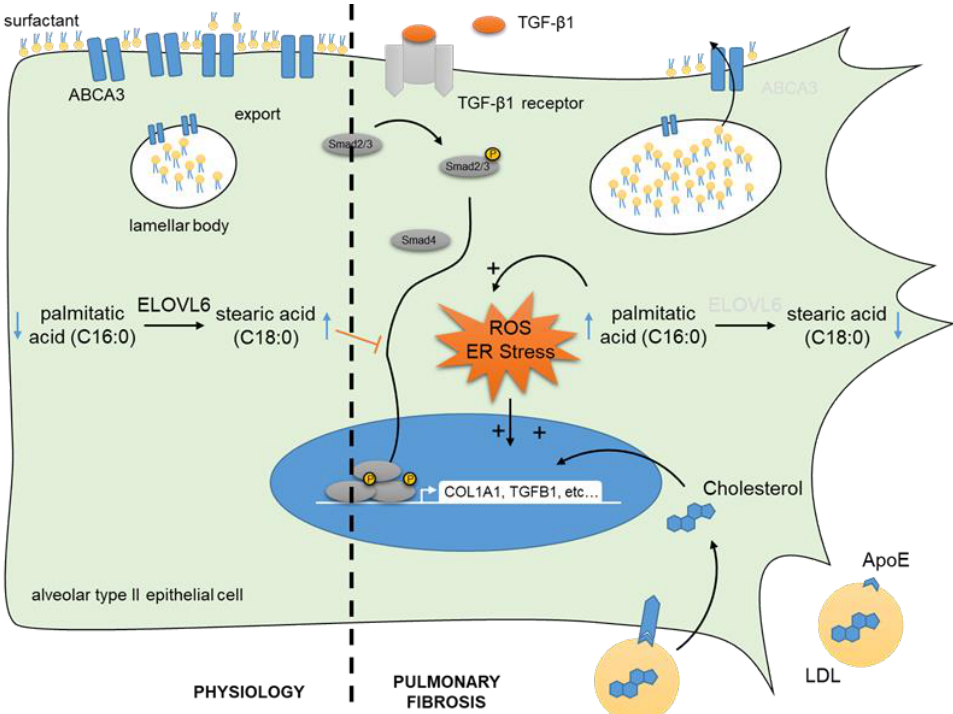
Figure 1. Altered lipid metabolism during fibrosis contributes to the activation of alveolar epithelial cells. Under physiological conditions, the elongation enzyme ELOVL6 allows fatty acid elongation and therefore promotes high intracellular stearic acid vs. palmitic acid. Stearic acid interferes with pro-fibrotic TGF- β /Smad signaling (red inhibition arrow). In parallel, ATII cells produce surfactant lipids (mainly PCs) which will be stocked in lamellar bodies and exported in the extracellular milieu in an ABCA3-dependant mechanism. During pulmonary fibrosis, ELOVL6 expression is decreased, favoring the accumulation of palmitic acid. High intracellular palmitic acid induces oxidative and ER stress, thus promoting TGF- β /Smad signaling and cell activation. This is enhanced by the accumulation of cholesterol and its derivates during fibrosis, which activates the expression of collagen and other ECM components. In addition, surfactant lipids accumulate within the cell due to decreased expression of ABCA3 under fibrotic conditions. This also leads to impaired surfactant formation in pulmonary